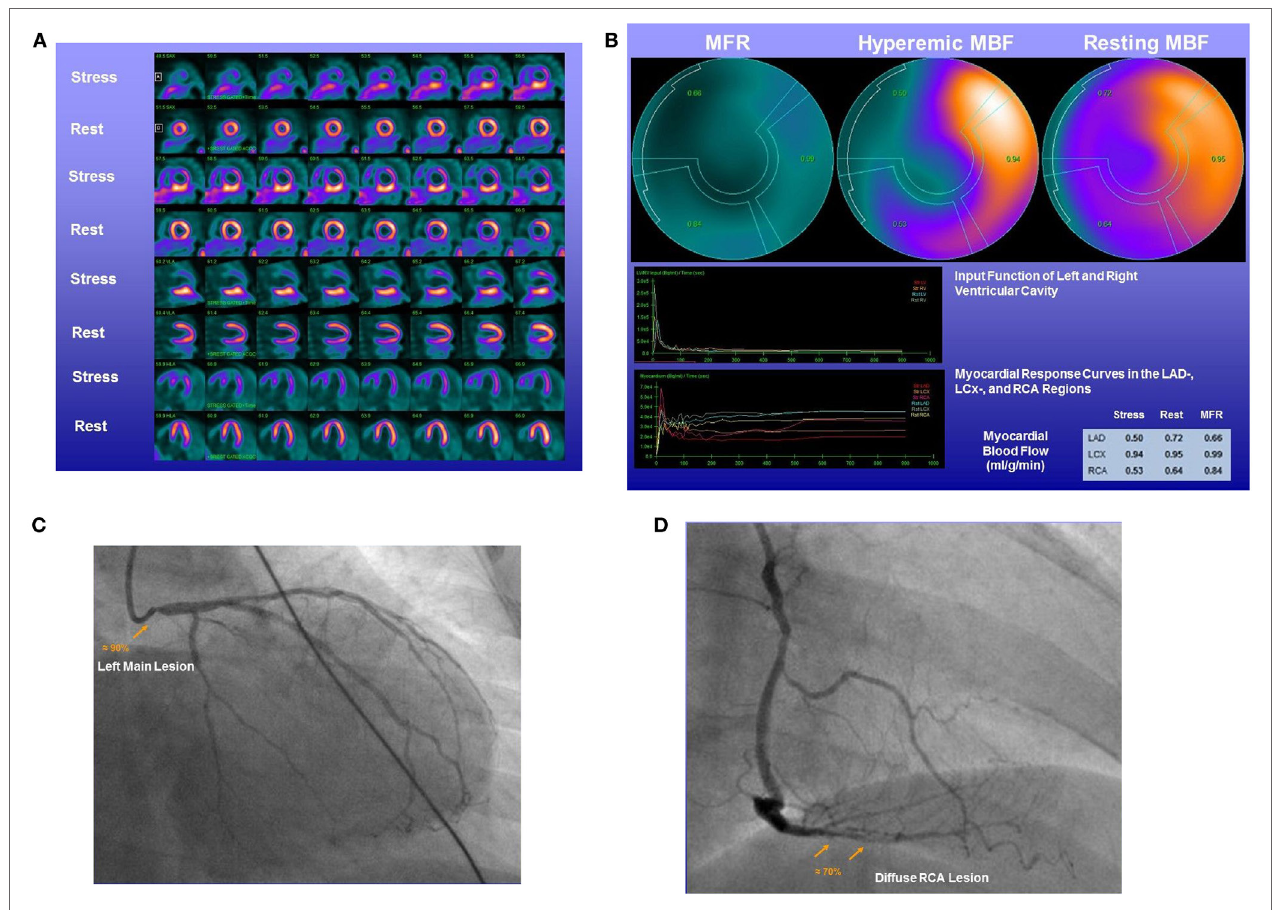
FiGURe 5 | 13 N-ammonia positron emission tomography/computed tomography in the assessment of complex CAD. A 58-year-old women with type 2 diabetes mellitus and dyslipidemia presented with effort-induced angina symptoms. (A) On stress 13 N-ammonia perfusion images, there is a severe decrease in radiotracer uptake of the anterior, anteroseptal, apical, and less severe in the anterolateral regions of the left ventricle, which becomes reversible on the rest images to signify large-sized, severe ischemia. On stress images, the inferior wall demonstrates pronounced radiotracer uptake likely due to overlapping high liver uptake that hampers an accurate evaluation. (B) Quantification of myocardial blood flows (MBFs) demonstrates a decrease of hyperemic MBFs from rest in all three major coronary artery territories of the left anterior descending artery (LAD)-, left circumflex artery (LCx)-, and right coronary artery (RCA) distribution. This resulted in regionally reduced myocardial flow reserves (MFRs) of 0.66 in the LAD-, 0.99 in the LCx-, and 0.84 in the RCA distribution, respectively. (C) Invasive coronary angiography signifies a high-grade lesion of the left main stem. (D) In addition, a diffuse ≈ 70% lesions in the distal RCA are noted. Consequently, the distinct reduction in MFR in the RCA distribution also unmasks the hemodynamic significance of the mid RCA lesions, apart from the left main, and the patient was referred for surgical revascularization of both